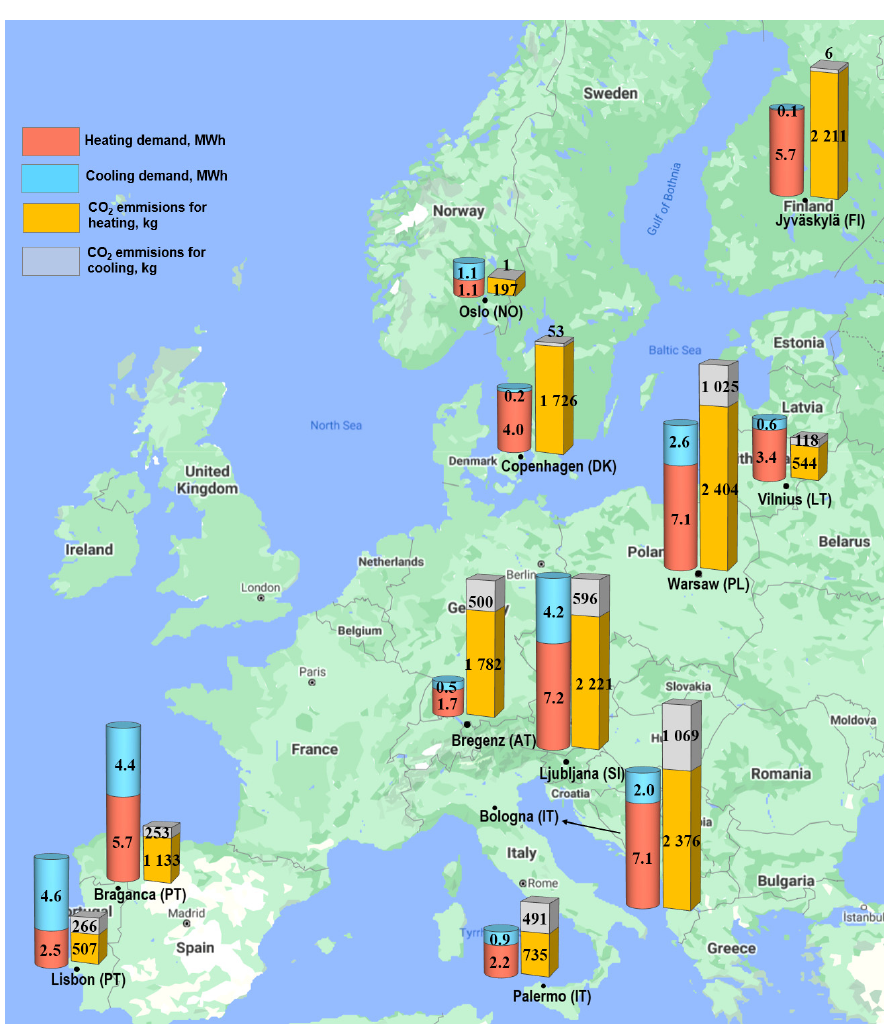
Figure 6. The aggregate primary energy demand for heating and cooling (MWh) in a building and the aggregate carbon dioxide emissions for heating and cooling (kg) with countries’ typical sources of energy.